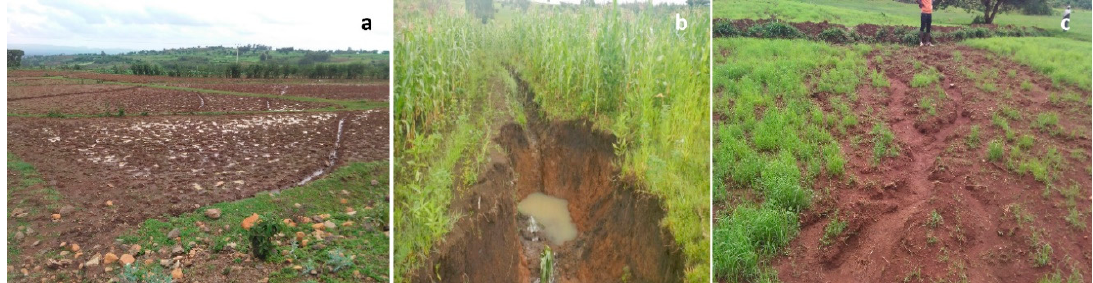
Figure 4. Soil and water conservation practices. ( a ) Fesses (plowed off-contour furrows; 20–30 cm wide and 10–15 cm deep) and 20–30 cm high bunds (green strips) in the Debre Mawi watershed in July 2018. Water is ponded at the surface, and the fesses carry off the excess water. Infiltration furrows uphill of the bunds have been filled with sediment and are not visible. ( b ) Infiltration furrow installed in 2012 in the saturated bottomland carries off interflow from the upland and caused the 2.5 m deep gully in the foreground. The photo was taken in August 2015. ( c ) Fifty to sixty centimeter wide rills formed by runoff concentrated by a bund on 18 July 2017.